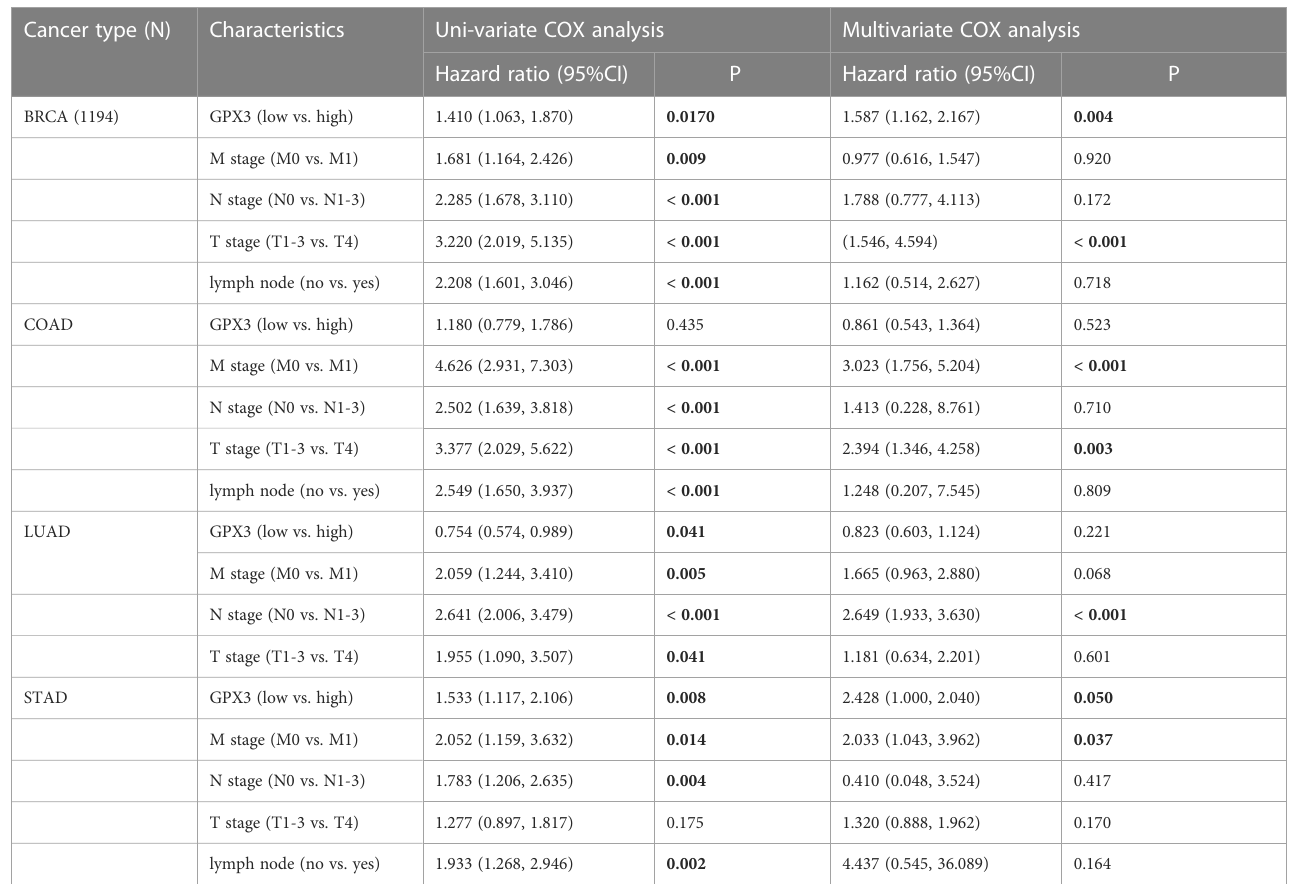
TABLE 2 Univariate and multivariate analyses of overall survival. Cancer type (N) Characteristics Uni-variate COX analysis Multivariate COX analysis